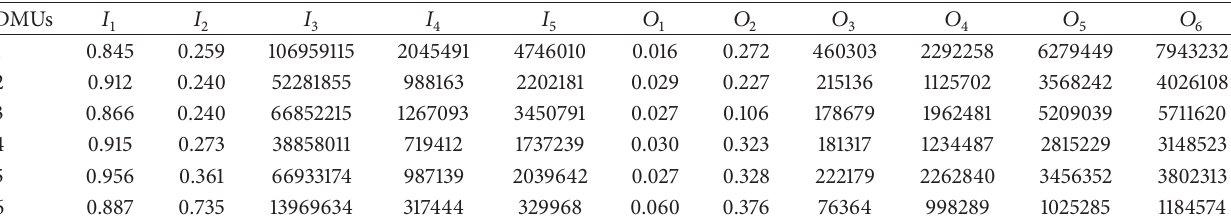
Table 3: Inputs and outputs (2007).